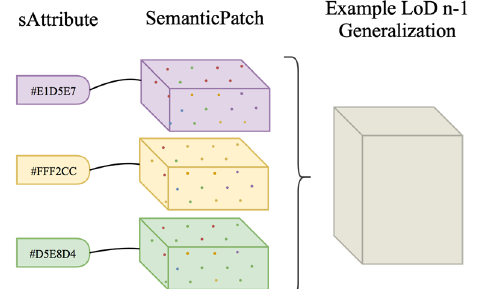
Figure 3 Example of a basic LOD n-1 Generalization of 3 SemanticPatches from a point cloud with color attributes